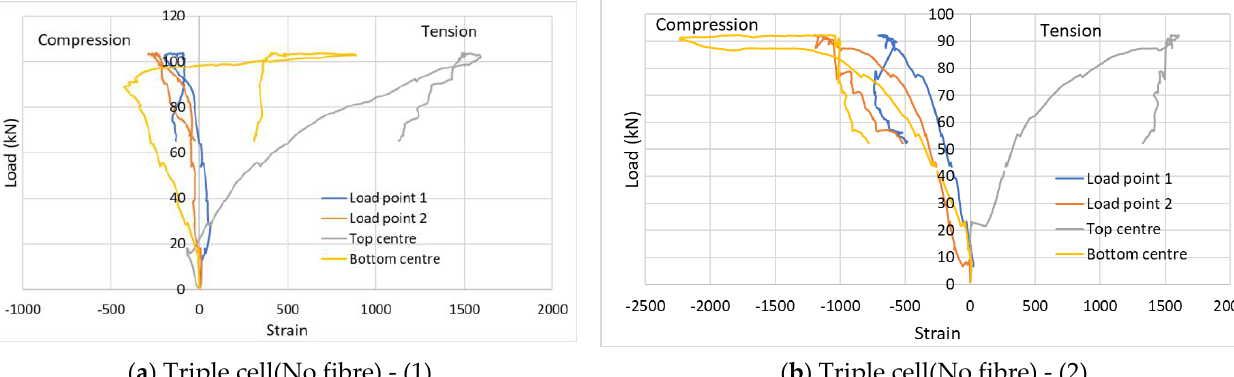
Figure 13. Strain mapping of triple-cell panels.